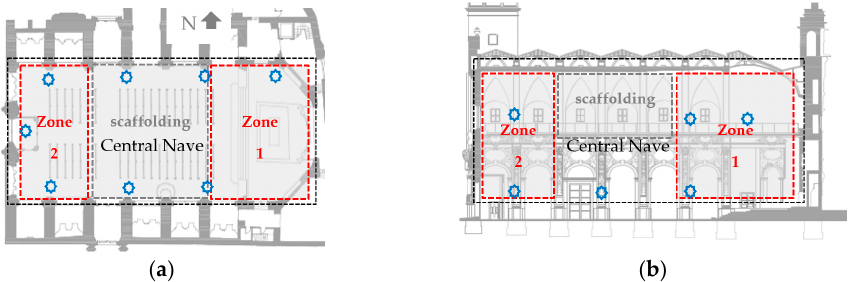
Figure 2. ( a ) Plan and ( b ) section of the main nave of the temple. The areas indicated in red corre- spond to two series of thermal 3D scans carried out every 30 min, between 10 a.m. and 7 p.m. on 16/09/2019 (Zone 2), at 10 a.m. on 17/09/2019, and at 10 a.m. on 18/09/2019. The blue dots represent the temperature and relative humidity measurement locations of environmental monitoring sys- tem (EMS) data collection during September 2019.